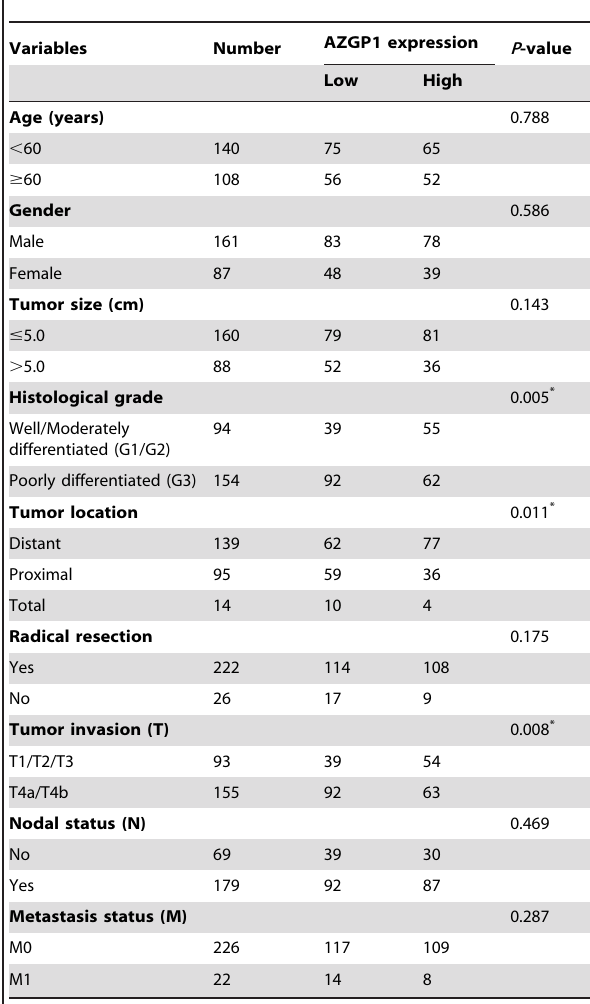
Table 1. Relationship between AZGP1 expression and clinicopathologic features of patients with gastric